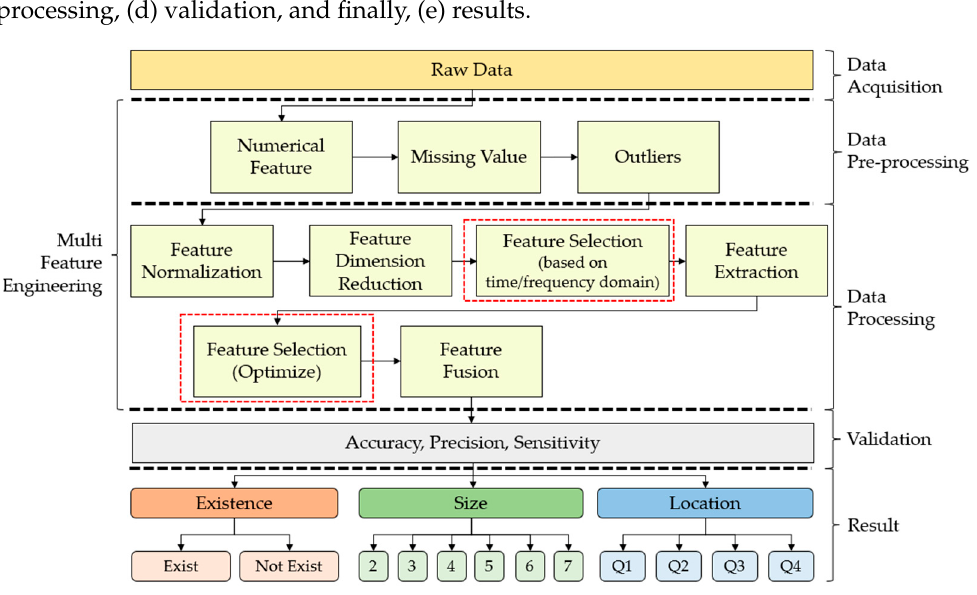
Figure 4. MSFS–BPSO flowchart of overall experimental process.